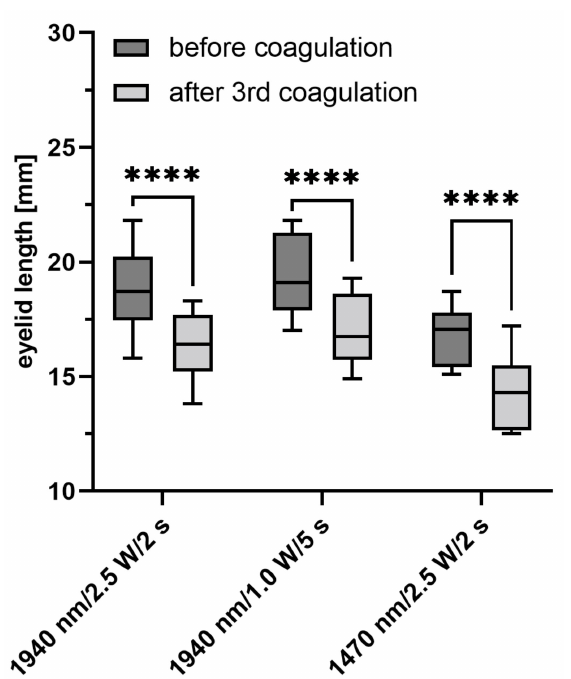
Figure 1. Changes in eyelid length before and after irradiation using three different laser settings. **** p <